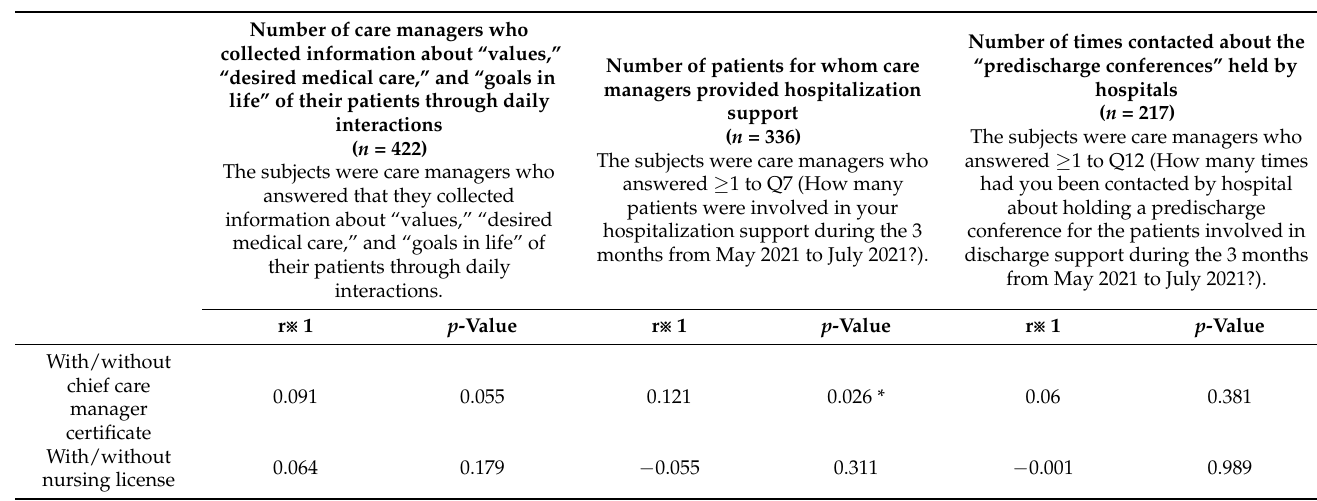
Table 5. Association between chief care manager certification status and nursing license status of care managers and the number of care managers who collected information about “values,” “desired medical care,” and “goals in life” of their patients through daily interactions, the number of care managers who were involved in the hospitalization of their patient, and the number of times contacted about the “predischarge conferences” held by hospitals.